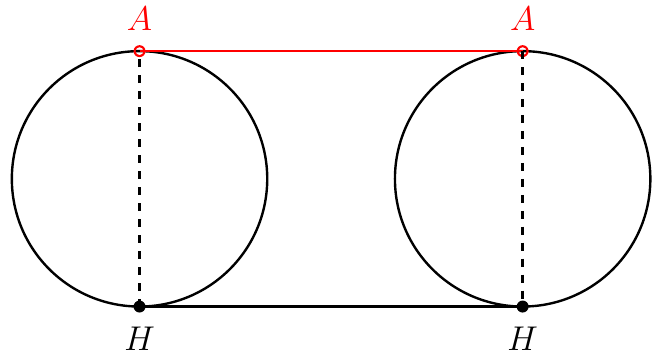
Figure 22 . Double-trace of one-point functions of operators with Hamiltonian